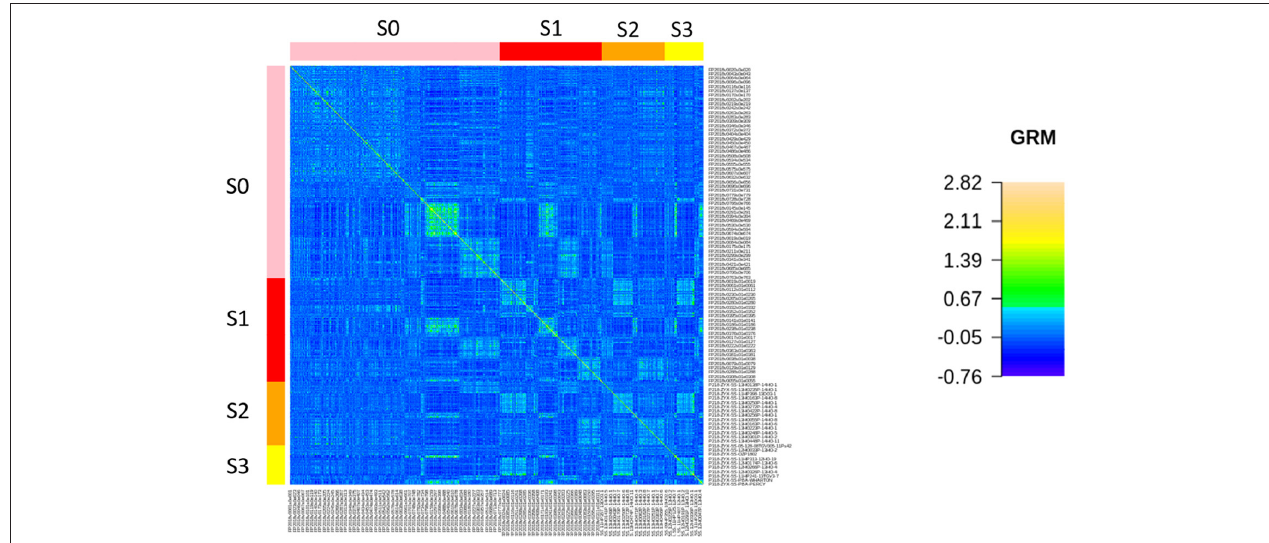
FIGURE 2 | Heatmap of the genomic relationship matrix (GRM) for field pea breeding stages represented with differed colors (S0_pink, S1_red, S2_orange, and S3_yellow). The colors within the GRM indicate the degree of relatedness between breeding lines (high relationships are shown in green, and low relationships are shown in